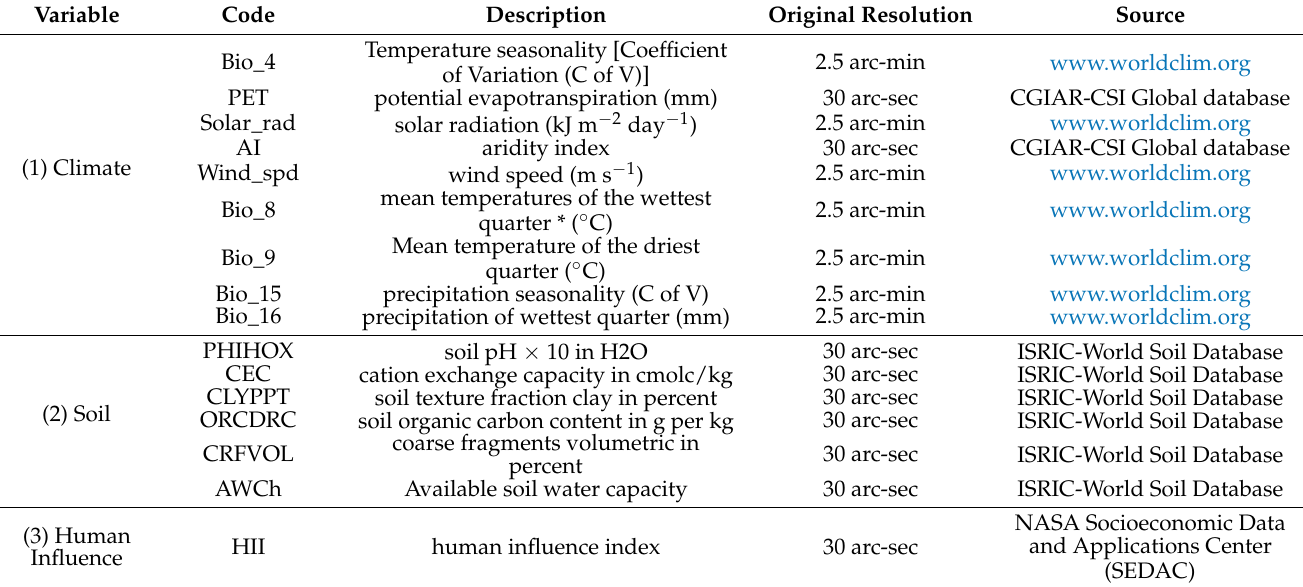
Table 1. List of the predictor variables used in the distribution modelling of P. juliflora . All data were standardized to 2.5 arc-min spatial